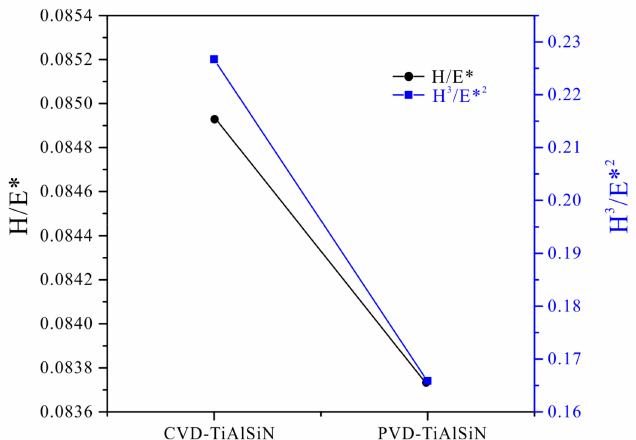
Figure 8. The H/E* and H 3 /E* 2 ratios of of CVD Ti 0.13 Al 0.85 Si 0.02 N and PVD Ti 0.31 Al 0.60 Si 0.09 - N